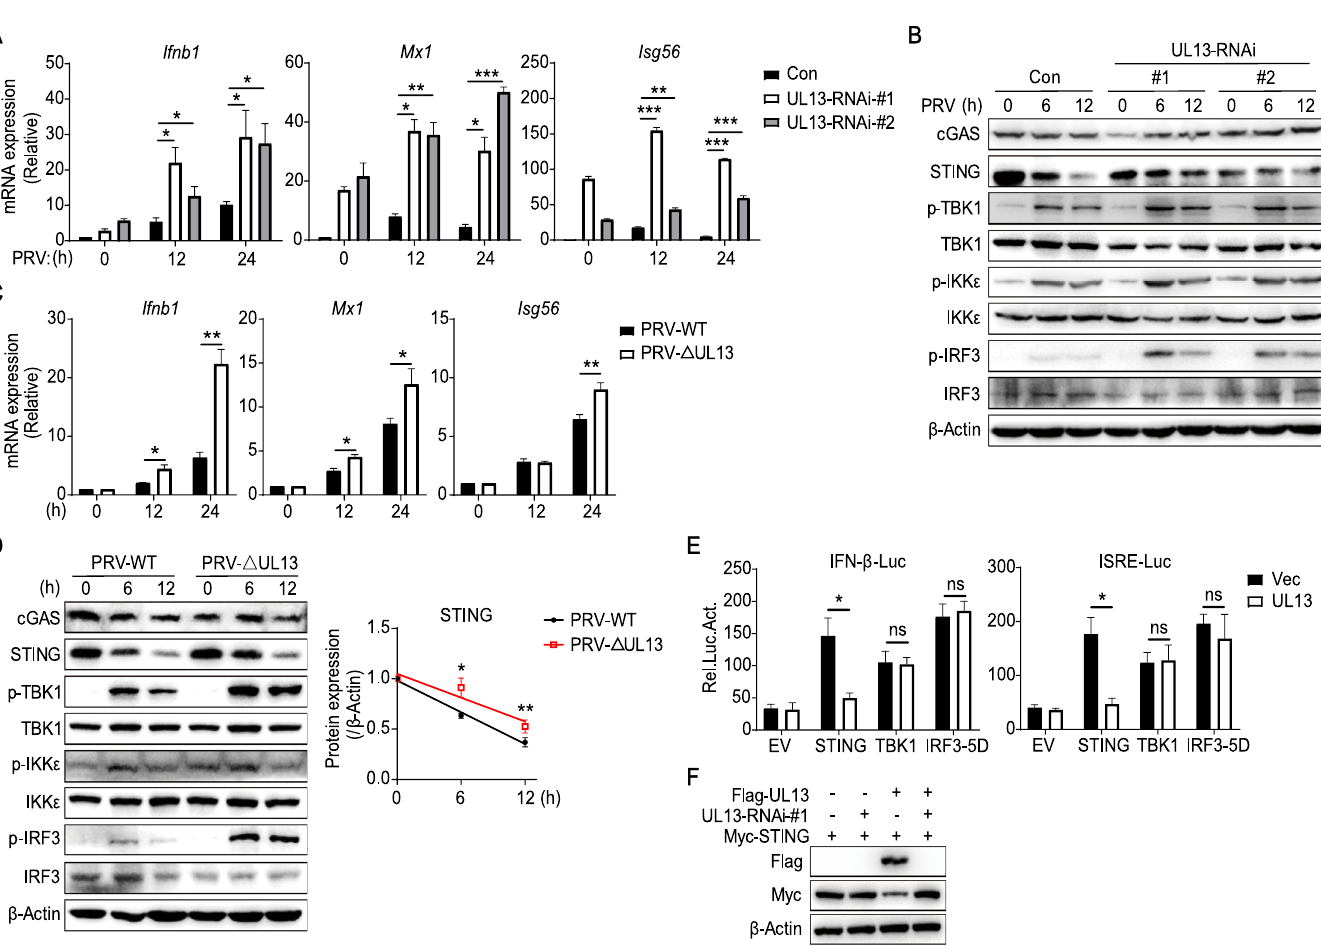
Fig 2. Knockdown of UL13 increases PRV-triggered antiviral responses. (A) qPCR analysis of PRV-induced transcription of Ifnb1 and downstream genes ( Mx1 , Isg56 ) in UL13-RNAi stable mouse embryonic fibroblasts (MEFs) and control cells infected with PRV (MOI = 1) infection for the indicated periods. (B) Immunoblotting analysis of cGAS, STING, and phosphorylation of downstream components in UL13-RNAi MEFs and control cells infected with PRV (MOI = 1) for the indicated times. (C and D) qPCR analysis of transcription of Ifnb1 and downstream genes ( Mx1 , Isg56 ) (C) or immunoblotting analysis of cGAS, STING, and phosphorylation of downstream components (D) in MEFs infected with wild type PRV (strain Bartha-K61, PRV-WT, MOI = 1) or UL13-deficient PRV (PRV- Δ UL13, MOI = 1) for the indicated times. Cumulative results for densitometric quantitation of STING were normalized relative to the levels of 0 min conditions (D, right). (E) Luciferase activities in UL13-PK-15 cells and control PK-15 cells cotransfected with IFN- β -luc reporter or ISRE-luc reporter and plasmids encoding STING, TBK1, or IRF3-5D or empty vector as indicated. Twenty-four hours after transfection, cell lysates were analyzed for luciferase activity. (F) Immunoblotting analysis of Flag-UL13 and Myc-STING expression in HEK293T cells cotransfected with Myc-STING, Flag-UL13 or UL13 shRNA plasmids as indicated for 24 h. Data are pooled from three independent experiments (A, C, D, right and E, mean ± SD) or representative of three (B, D, left) or two (F) independent experiments. � p < 0.05, �� p < 0.01 and ��� p < 0.001, ns, not significant (Student’s t